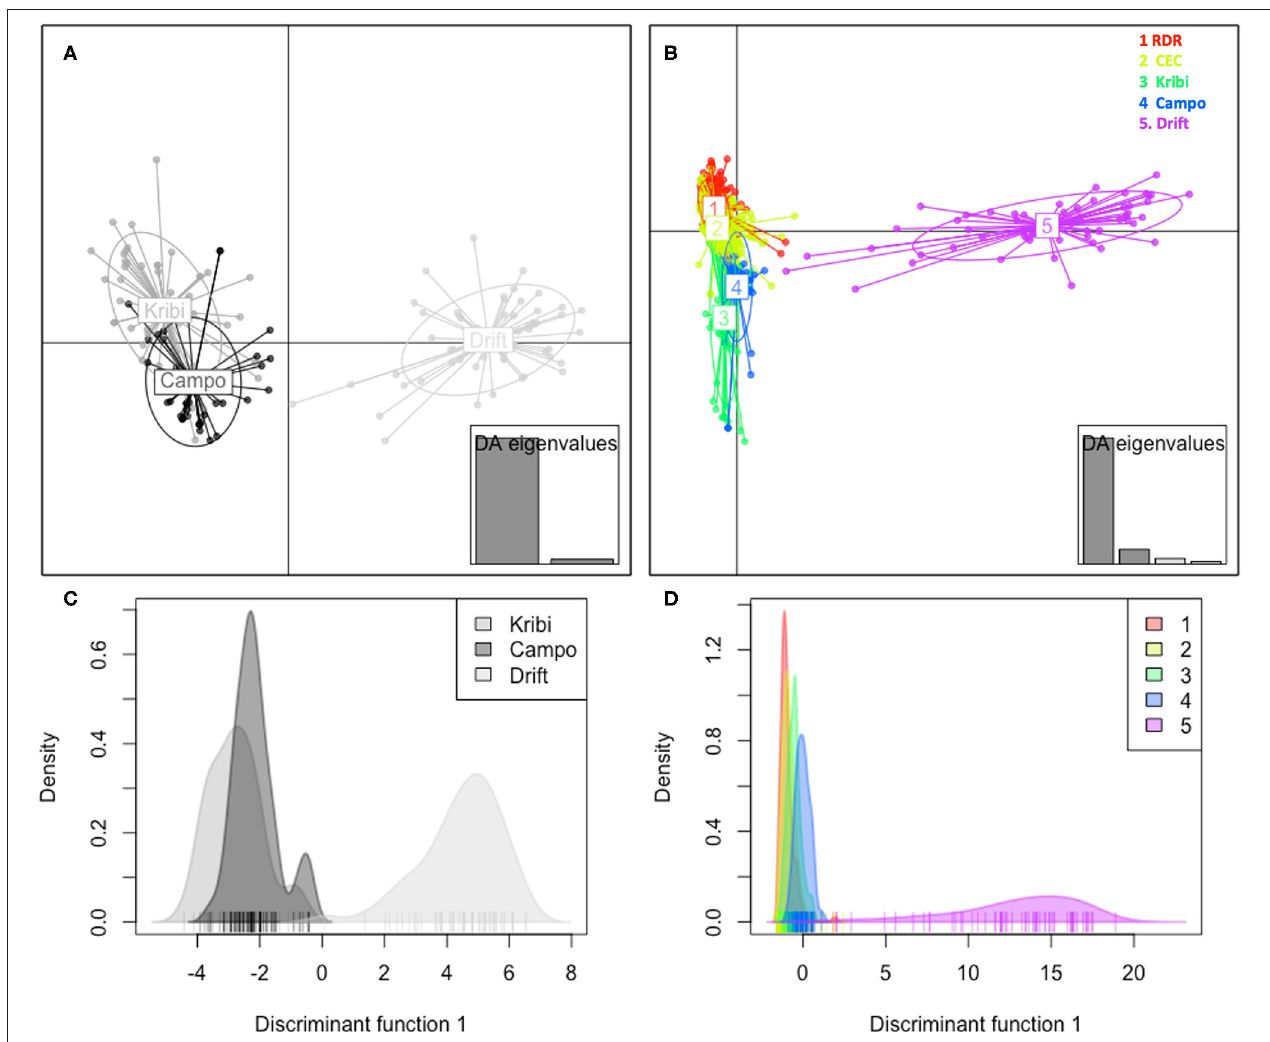
FIGURE 3 | Discriminate analysis of principal components (DAPC) clustering of drift propagules with the closest mangrove estuaries (Kribi and Campo) (A) and with the other central and northern estuaries (B) along the Cameroonian coastline. DAPC was performed with original populations and colors represent the different clusters at K = 2 for the analyses using Kribi, Campo, and Drift propagules (A) , and K = 4 for the analysis including all other sites of the Cameroonian range (B) [i.e., RDR, Rio Del Rey Estuary; CEC, Cameroon Estuary complex; Kribi, Lokoundje Estuary, Campo (Ntem Estuary), see Figure 1 ]. Additionally, discriminant analyses of each corresponding data set are shown under each respective DAPC result (C,D) ; the first discriminant function (x-axis) vs. the smoothed density of observations